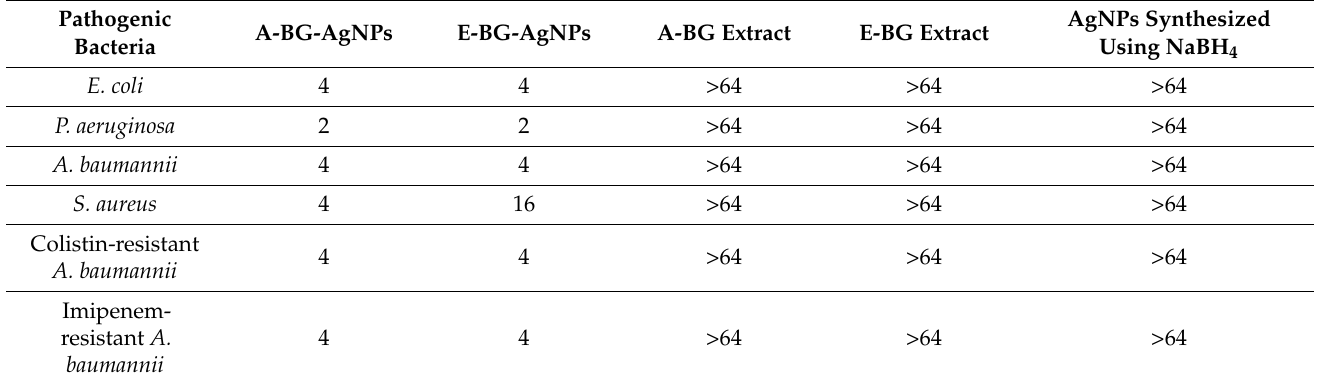
Table 1. Minimum inhibition concentration ( µ g/mL) of different Ag NPs and BG extracts.